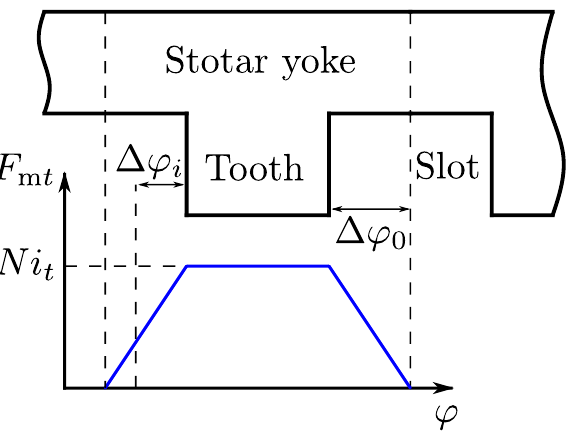
Figure 5. Total magnetic potential sources in the tooth and slots beside it in the radial